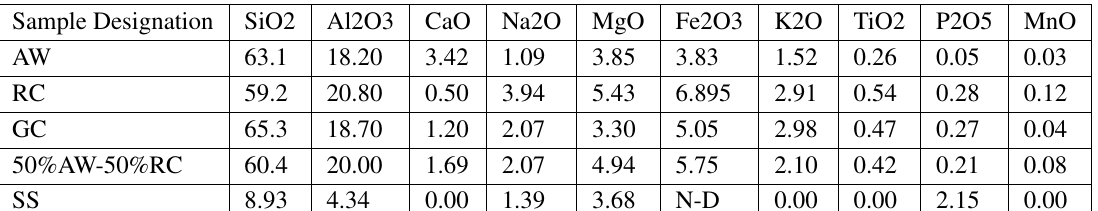
Table 3. XRF Analysis of Raw Materials and Raw Materials Mixtures